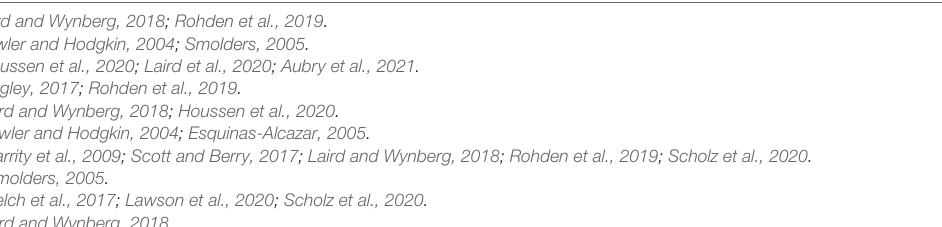
Assumptions underpinning the multilateral system of the ITPGRFA